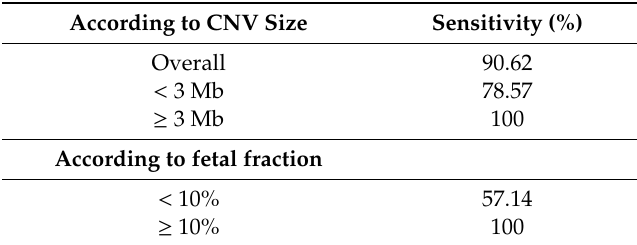
Table 2. Evaluation of Copy Number Variation (CNV) detection.